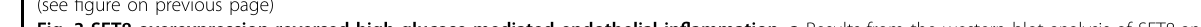
overexpression inhibited SET8 expression (Fig. 6h, i). These data indicated that SET8 and FOXO1 inhibited each other in HUVECs.